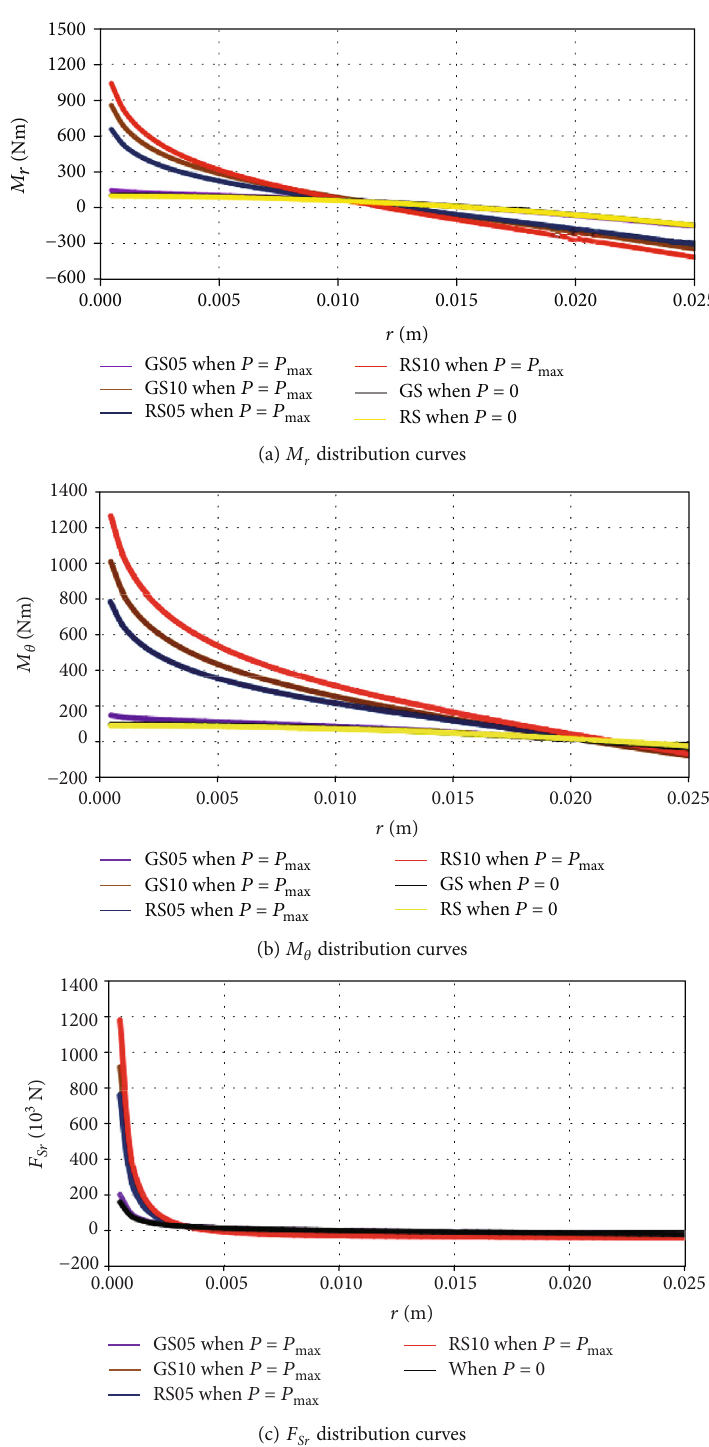
Figure 10: Internal force distribution